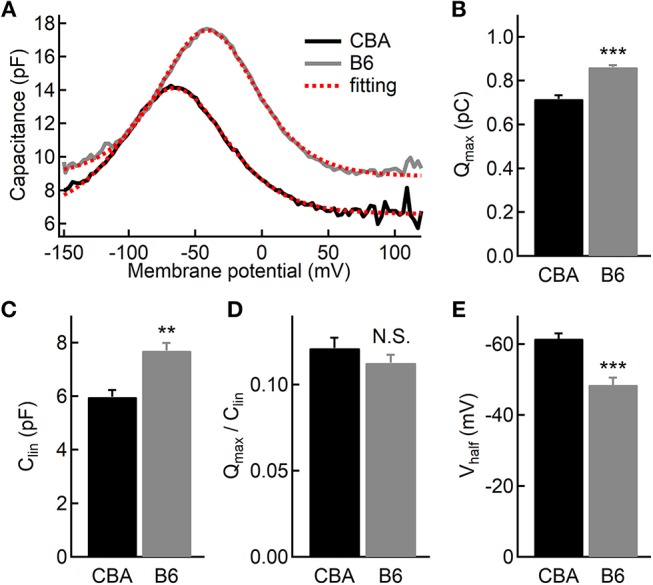
Electromotility of outer hair cells (OHCs). (A) Capacitance recordings from two OHCs in response to a voltage ramp. The dashed lines in red depict two-state Boltzmann fitting (see the Materials and Methods). (B–D) Both non-linear (B) and linear (C) capacitances are significantly larger in OHCs from B6 mice, but the ratio of the two parameters is comparable (D) between the two mouse strains. (E) OHCs from B6 mice had a more positive half-activation voltage (Vhalf). N.S. means p > 0.05, ** means p < 0.01 and *** means p < 0.001.